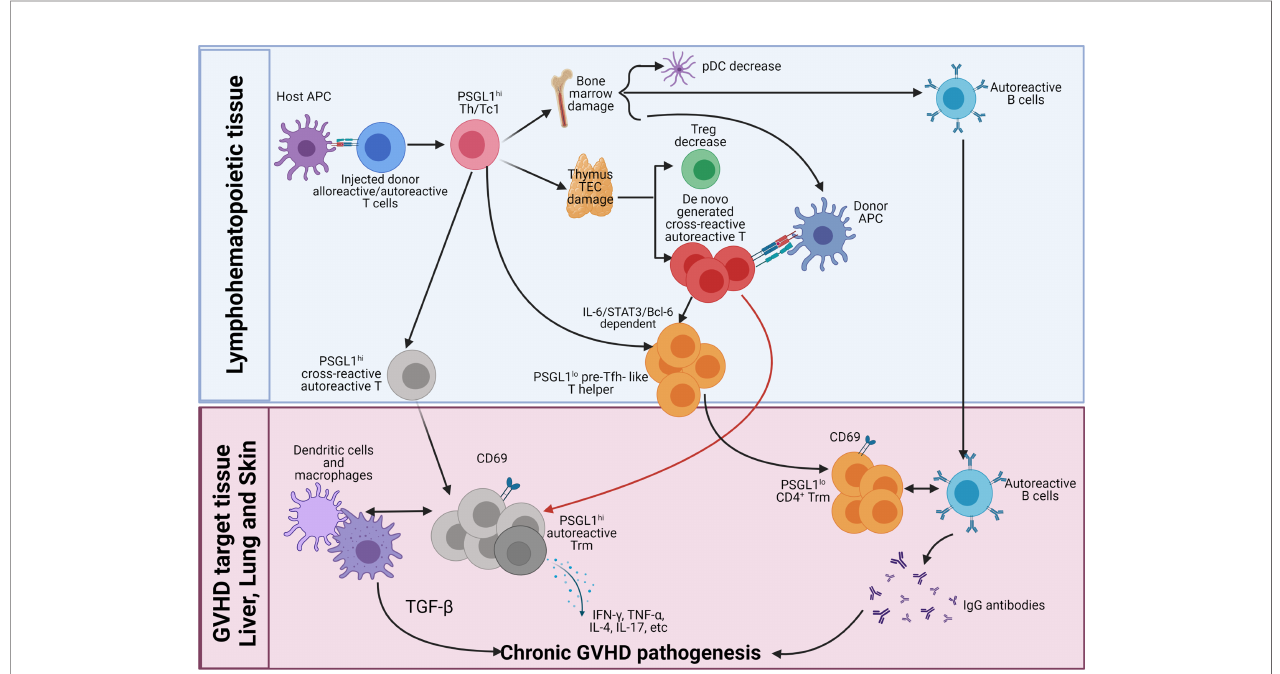
FIGURE 2 | Pathogenesis of chronic GVHD. Early after allo-HCT, donor-type CD4 + , and CD8 + T cells including autoreactive CD4 + T cells are activated by host APCs in the lymphoid tissues. The majority of the injected alloreactive T cells differentiate into PSGL1 hi Th1/Tc1 cells to cause acute GVHD. At the same time, some of the autoreactive CD4 + T cells differentiate into PSGL1 lo CD4 + pre-Tfh-like cells via IL-6-Stat3-BCL6 pathway, and they interact with activated donor B cells to augment antibody production, and some of them remain PSGL1 hi . The Th1/Tc1 cells in fi ltrate GVHD target tissues including thymus and bone marrow. Damage of thymic medullary epithelial cells (mTECs) leads to decreased generation of thymic Tregs (tTreg) cells and increased release of autoreactive T cells that are cross- reactive with donor antigen-MHC complex and host antigen-MHC complex. Damage of bone marrow microenvironment results in increased production of autoreactive B cells and reduced production of tolerogenic plasmacytoid dendritic cells (pDCs). Acute GVHD destroys lymphoid tissues. As acute GVHD subside into chronic GVHD, alloreactive pathogenic memory T, especially CD4 + memory T cells, that can cross-react with donor APCs become autoreactive CD4 + T cells and gather in the GVHD target tissue. The de novo -generated autoreactive CD4 + T cells from damaged thymus also in fi ltrate the GVHD target tissues. The autoreactive CD4 + T cells from both sources interact with donor-type APCs and become CD69 + tissue resident memory T (Trm) cells in the tissues. The PSGL1 hi autoreactive Trm cells interact with DCs and macrophages to mediate pathogenesis via their production of cytokines such as TGF- b , IFN- g , TNF- a , IL-4, IL-17, and IL-22. The pre-Tfh-like PSGL1 lo CD4 + helper T cells interact with B cells to augment memory B-cell differentiation into plasma cells that produce IgG autoantibodies. IgG autoantibodies enter circulation and deposit in the GVHD target tissues such as skin to augment GVHD